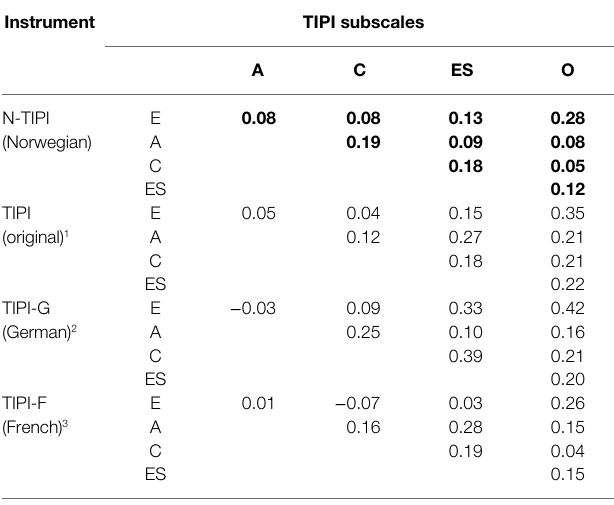
TABLE 5 | Correlations between the TIPI-subscales, N-TIPI compared with the original TIPI and two other versions. Instrument